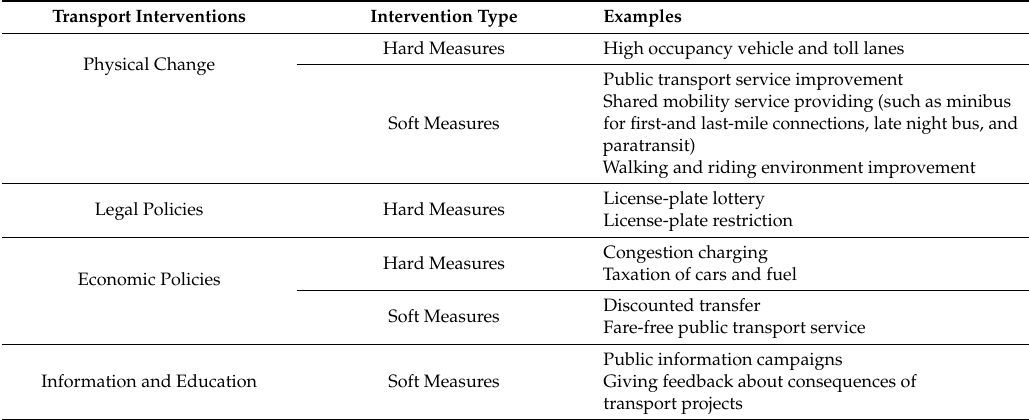
Table 1. Main strategies of transport